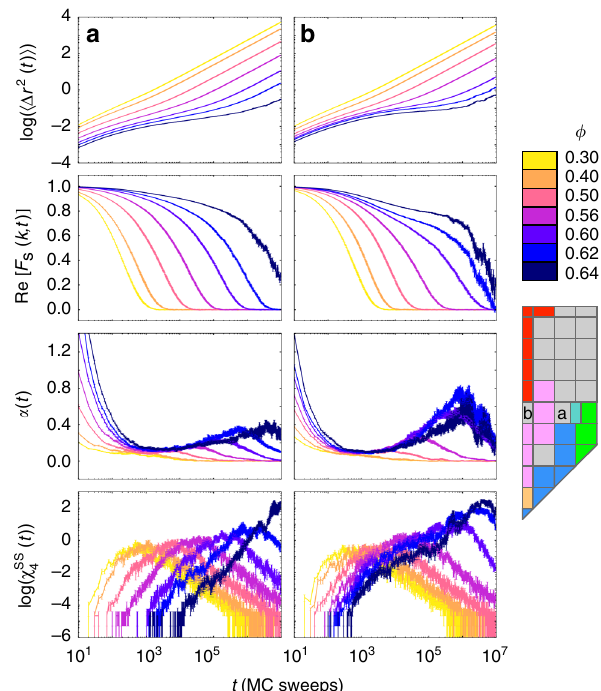
Fig. 2 Dynamical signatures of glass formation in two example systems. Panels show the mean-squared displacement 〈 Δ r 2 ( t ) 〉 , the real part of the ( t ), and the self-part of the four-point susceptibility χ SS